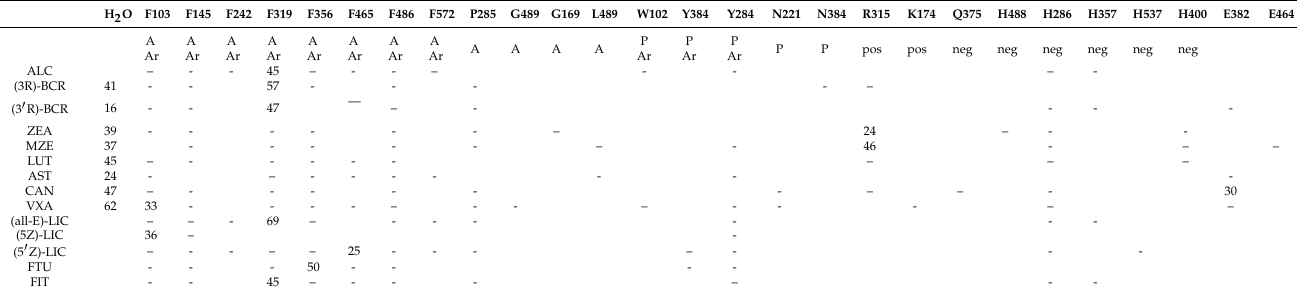
Table 7. PLIF results for BCO2. The first row lists the residues (one-letter coding). The second row de- scribes the nature of the residues: A = non-polar; AAr = non-polar aromatic; P = polar; PAr = polar aro- matic; neg = negatively charged; pos = positively charged. ALC = α -carotene; BCR = β -cryptoxanthin; ZEA = (3 R ,3 (cid:48) R )-zeaxanthin; MZE = (3 R ,3 (cid:48) S , meso )-zeaxanthin; UT = (3 R ,3 (cid:48) R )-lutein; CAN = canthax- anthin; AST = (3 S ,3 (cid:48) S )-astaxanthin; VXA = (3 S ,3 (cid:48) S )-violaxanthin; LIC = lycopene; FTU = (15 Z )- phytofluene; FIT = (15 Z )-phytoene. For all carotenoids, the various protein residues with which interaction is found for at least one time point during production are marked with a cross. Each cross represents the interaction of each atom interacting with the amino acid residue. In the cases of inter- action with solvent, it is reported how many water molecules the ligand interacts with. The numbers in the third column express the percentage of interaction between the residue (columns) and the carotenoid (rows). In all cases, two crosses should also be marked (omitted) except for (3 R ,3 (cid:48) R )-lutein and (3 S ,3 (cid:48) S )-astaxanthin where the highest frequency is with water (48% and 36%, respectively).